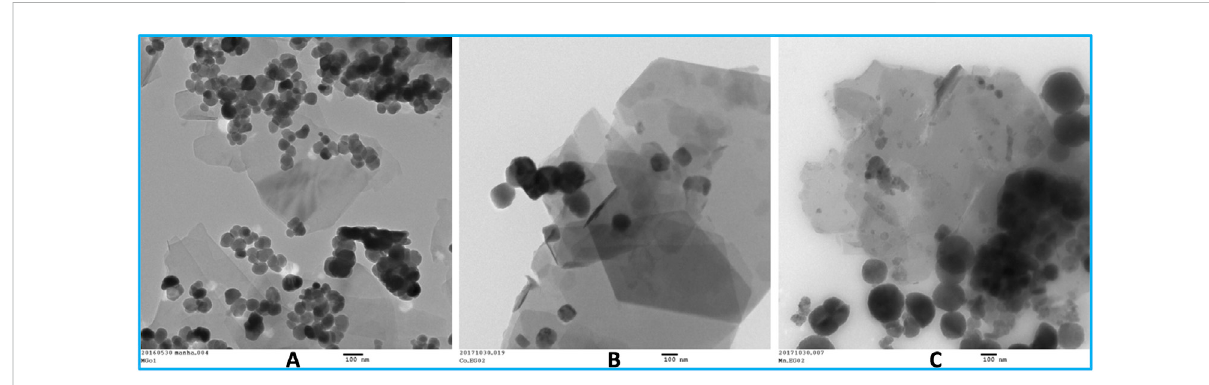
FIGURE 3 TEM images of nanocomposites: (A) Fe 3 O 4 /GNPs; (B) CoFe 2 O 4 /GNPs and (C) MnFe 2 O 4